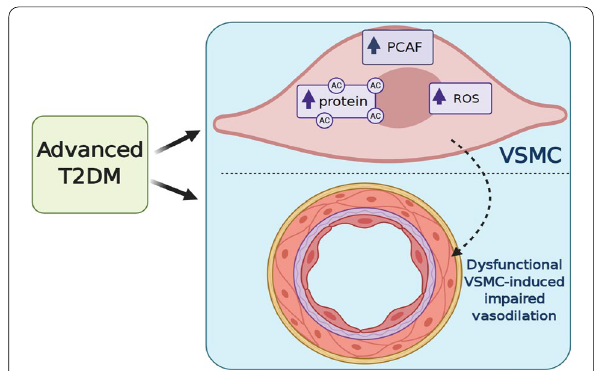
Fig. 8 Schematic summary of the present study. Advanced T2DM leads to increased global lysine acetylation (AC) and PCAF expression in association with elevated ROS formation in VSMCs, which may be contributing to dysfunctional VSMC‑induced impaired vasodilation. Created with